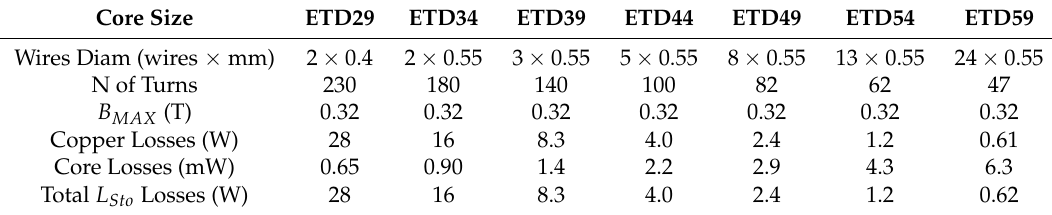
Table 6. Main Inductor Design Outputs for D = 0.05 ( L Sto = 760 µ H).